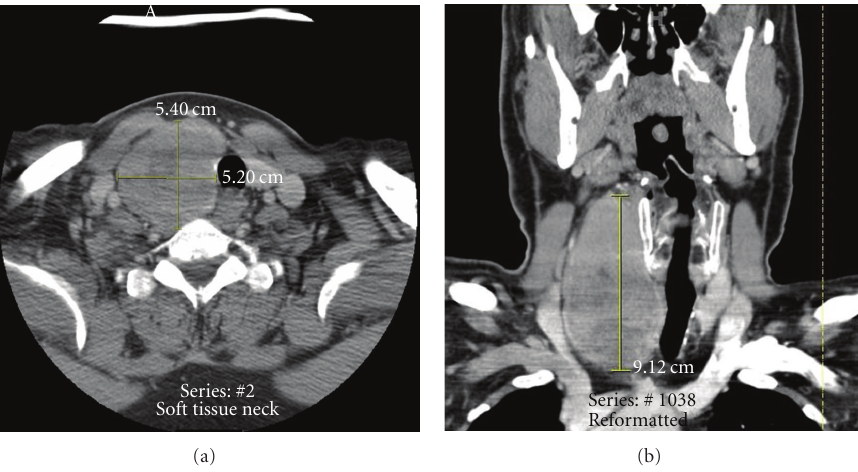
Figure 1: Preoperative computed tomography (CT) of the anaplastic thyroid carcinoma. (a) Axial view with contrast revealing a heterogeneous mass that is intimately associated with the trachea and pushes it toward the left side of the neck but free of the common carotid artery and the esophagus. (b) Coronal view with contrast demonstrating the craniocaudal extent and intimate tracheal involvement of the